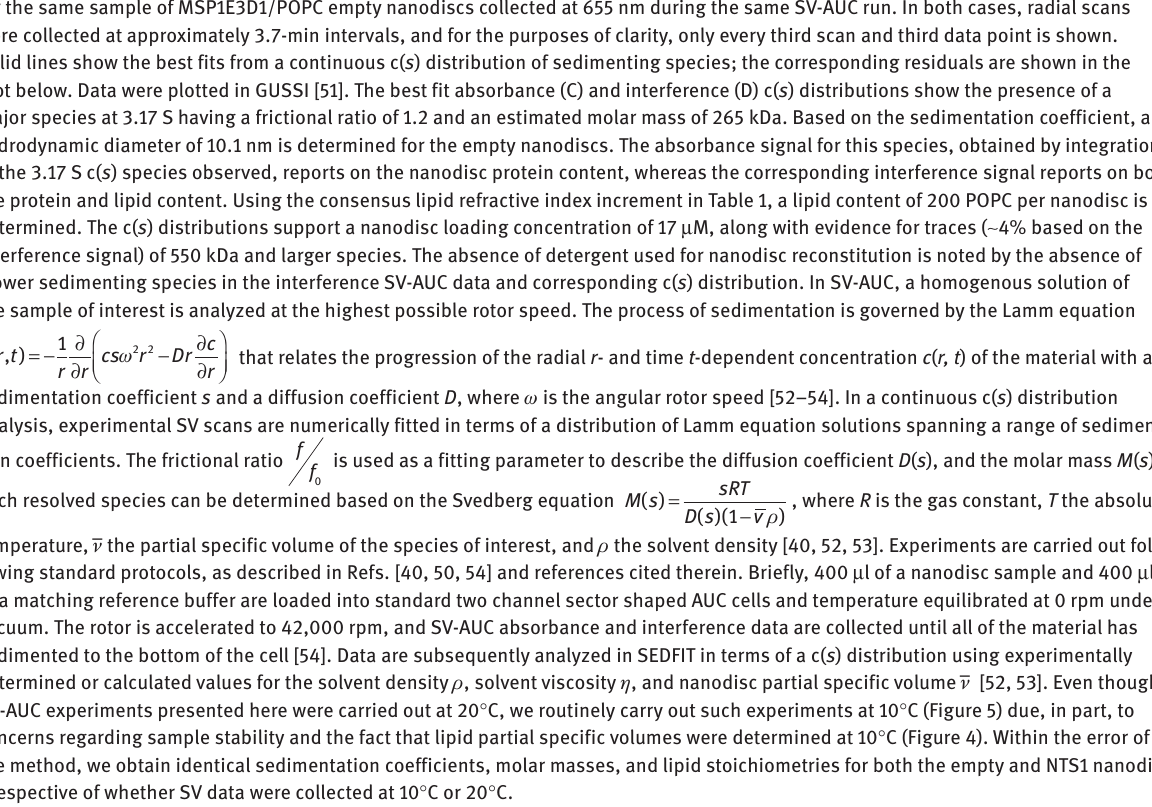
Figure 3: Sedimentation velocity of MSP1E3D1 nanodiscs reconstituted with POPC. (A) Absorbance sedimentation velocity scans for a sample of MSP1E3D1/POPC empty nanodiscs collected at 42,000 rpm, 20 ° C and 280 nm. (B) Interference sedimentation velocity